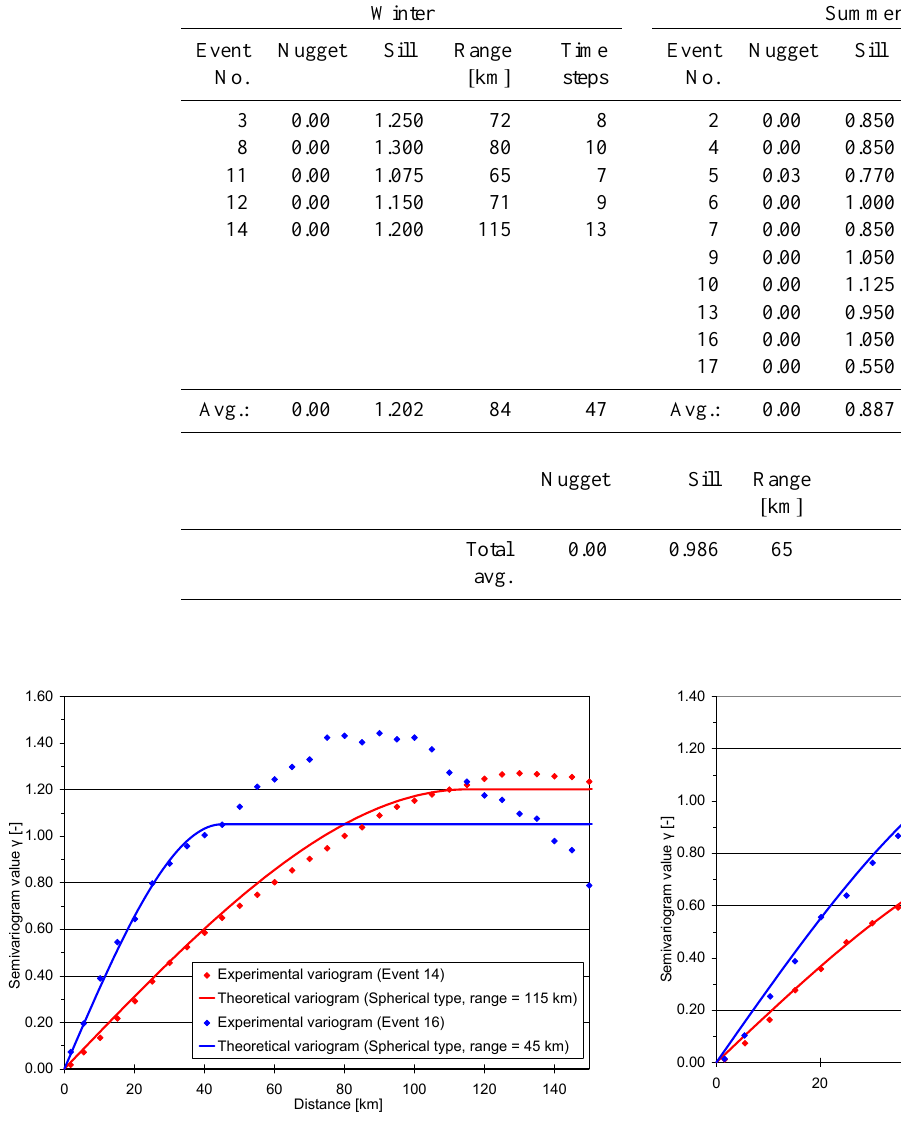
Fig. 2. Experimental and theoretical semivariograms for two pre- cipitation events.